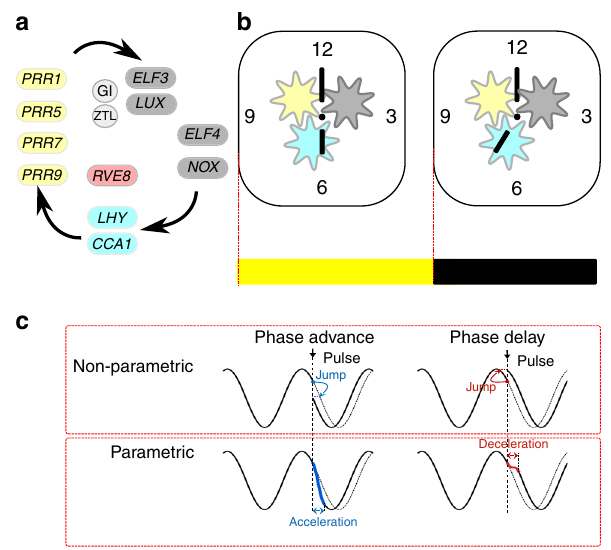
Fig. 1 Circadian oscillators are entrained timekeepers. a The circadian oscillator contains a network of transcriptional regulators. The components regulate each other in a temporal series, indicated by the fl ow of the arrows. The extensive regulation between components has been omitted for clarity; for details, see references in the text. The components can be grouped functionally as MYB-like repressors (cyan), MYB-like activators (red), pseudo response regulators (yellow), nocturnal regulators (dark grey) and proteins involved in protein stability (light grey). b The circadian oscillator is often conceptualised as a mechanical clock, with “ cogs ” made up of the functional groups of transcriptional regulators, “ hands ” that provide a read-out of time and the clock is set to a new time at light (yellow box) and dark (black box) interfaces (red dotted line). c Entrainment is thought to occur through non-parametric changes that jump from one point in the cycle to another in an almost instantaneous change in state of the oscillator and parametric changes that require acceleration or